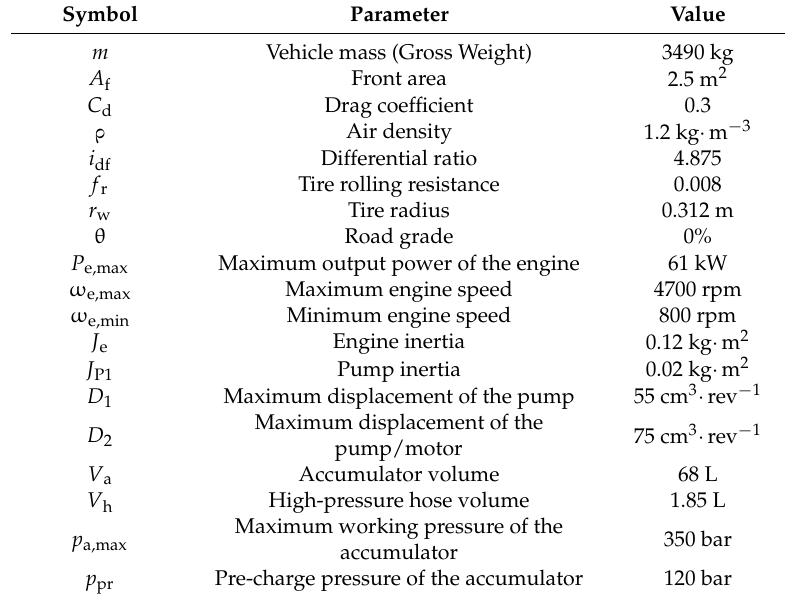
Table 1. System Parameters.